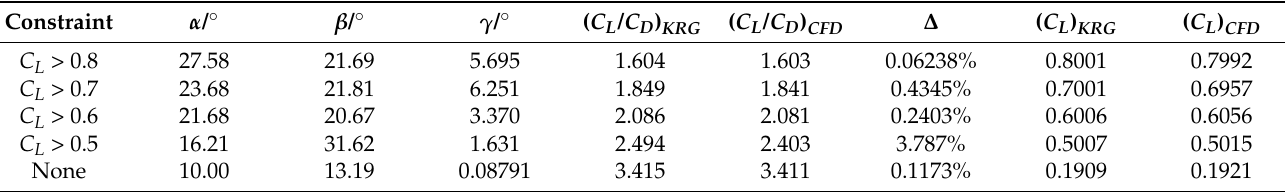
Table 2. Results of constrained optimizations under different C L constraints.